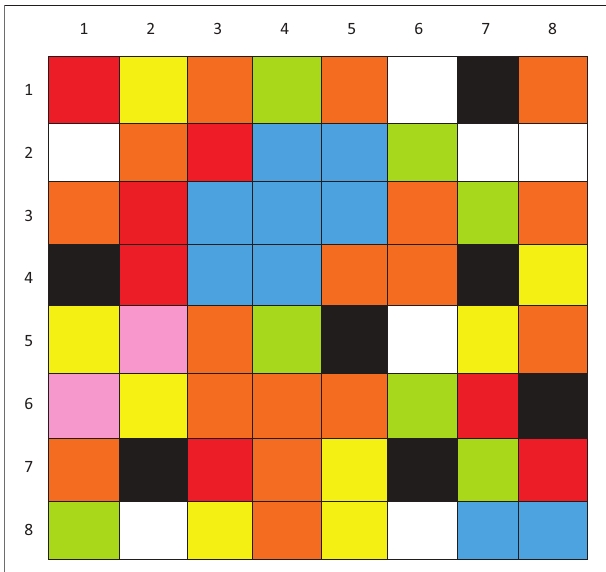
FIGURE 4: Will this function be injective?